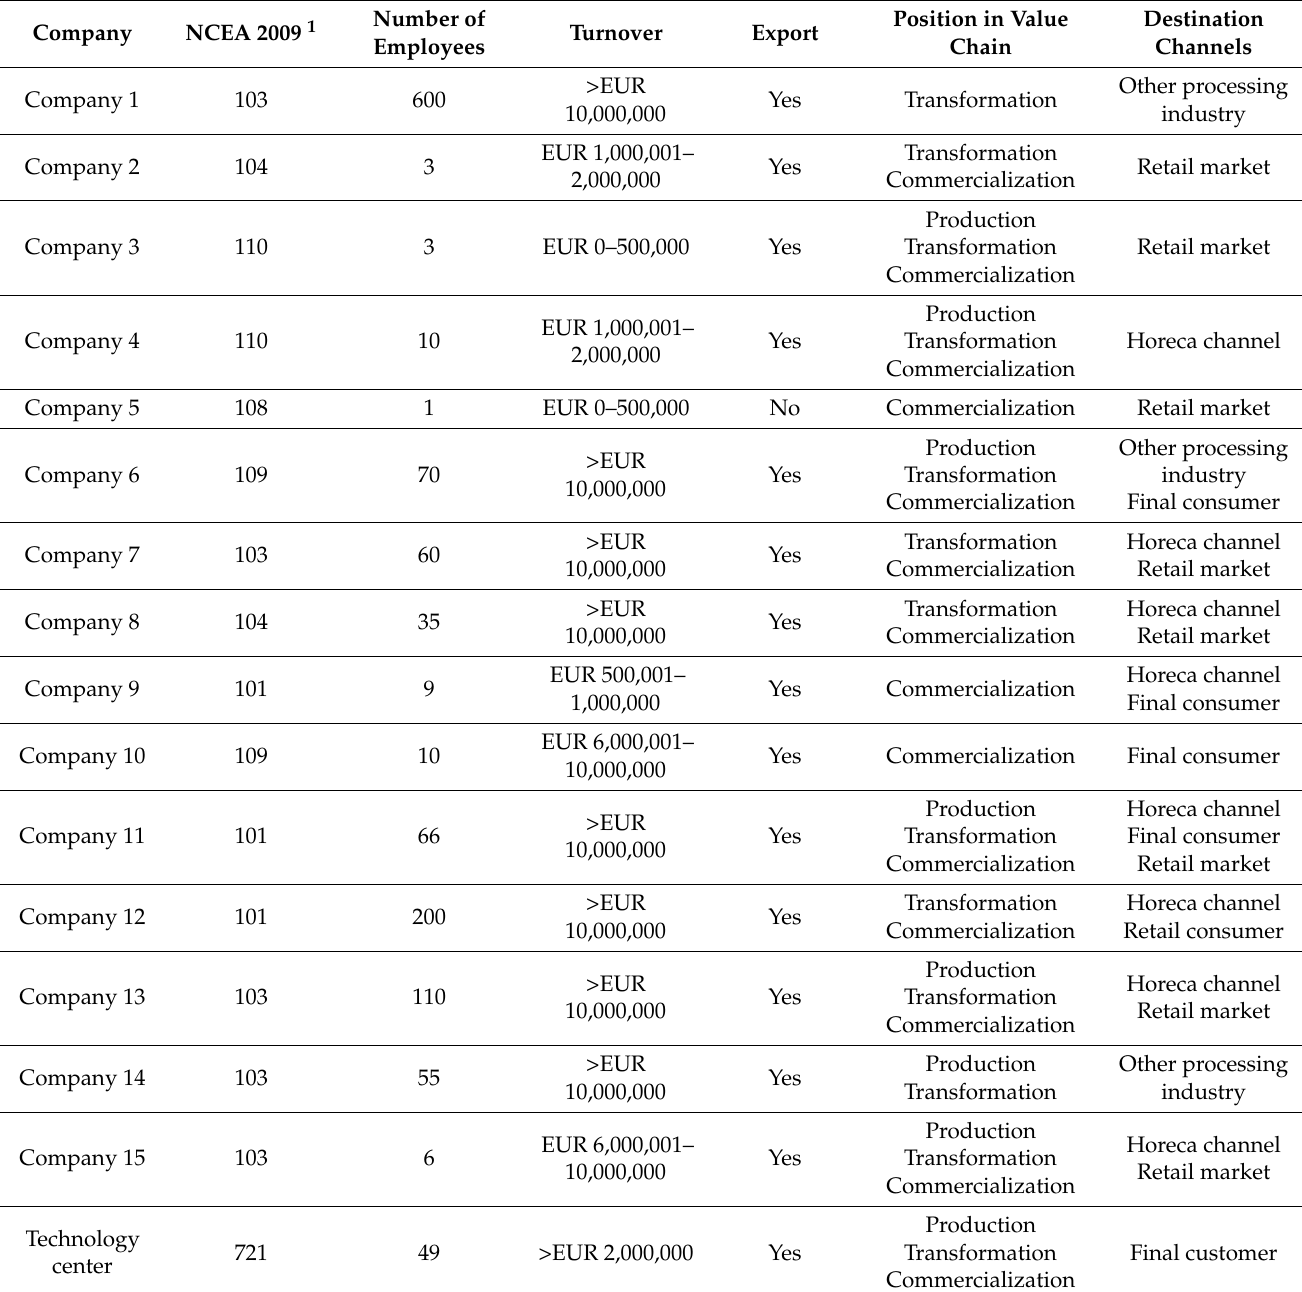
Table 2. Characteristics of the organizations